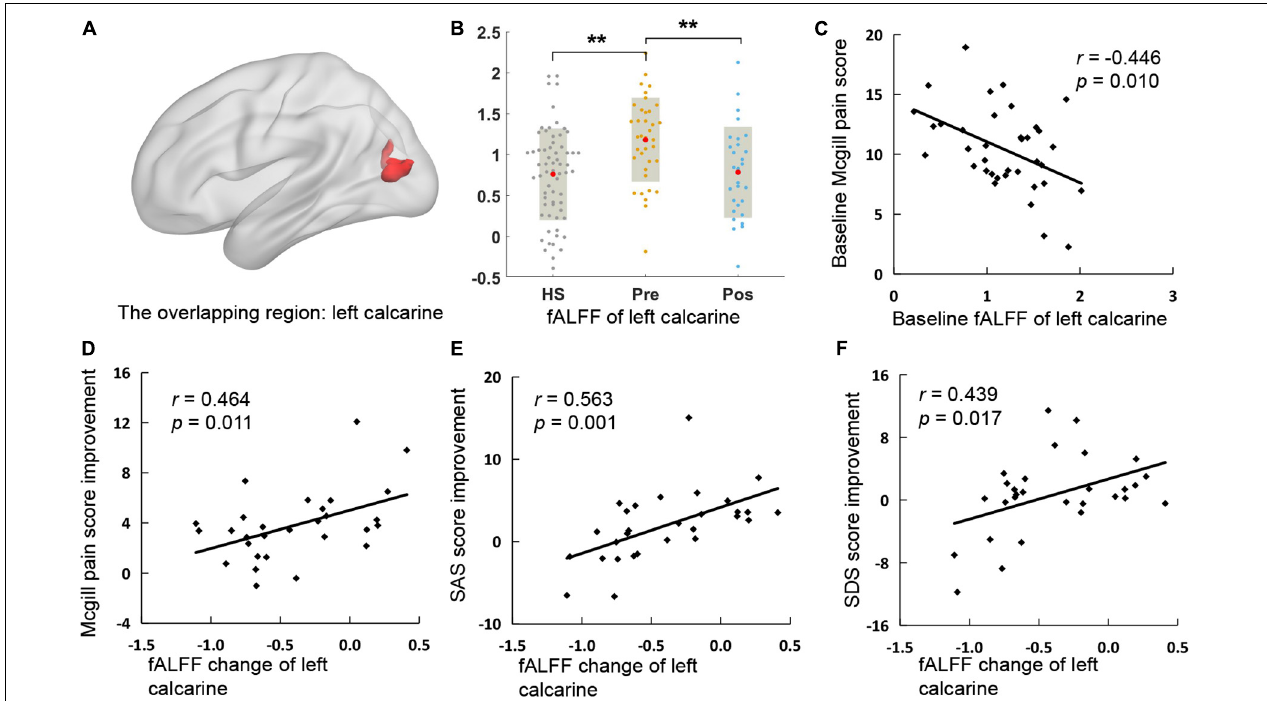
FIGURE 3 | The overlapping region and its correlation with clinical symptoms. (A) Is the location of the overlapping region. (B) Is the comparison of fALFF of the overlapping region among HS and the baseline and after treatment of CSAP patients. (C) Illustrates the correlation between the baseline fALFF of the overlapping region and the baseline McGill pain score in CSAP patients. (D–F) Illustrate the correlations between the fALFF change of the overlapping region and improvements of clinical symptoms after treatment. HS, healthy subjects; pre, pre-treatment; pos, post-treatment; fALFF, fractional Amplitude of Low-Frequency Fluctuation; SAS, self-rating anxiety scale; SDS, self-rating depression scale. * p < 0.05; ** p < 0.01; *** p <